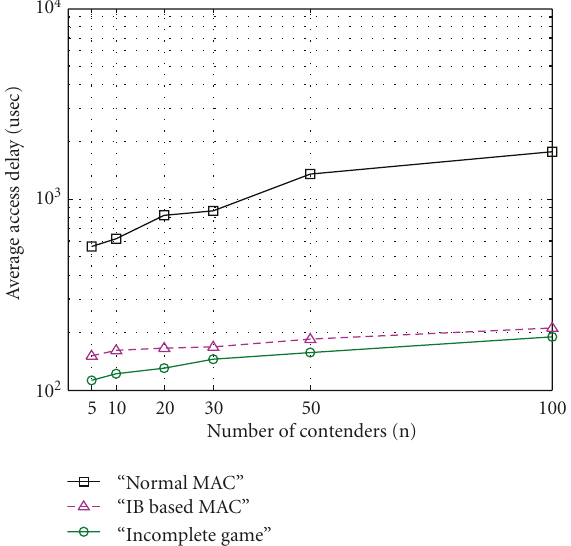
Figure 8: Average access delay versus number of nodes.